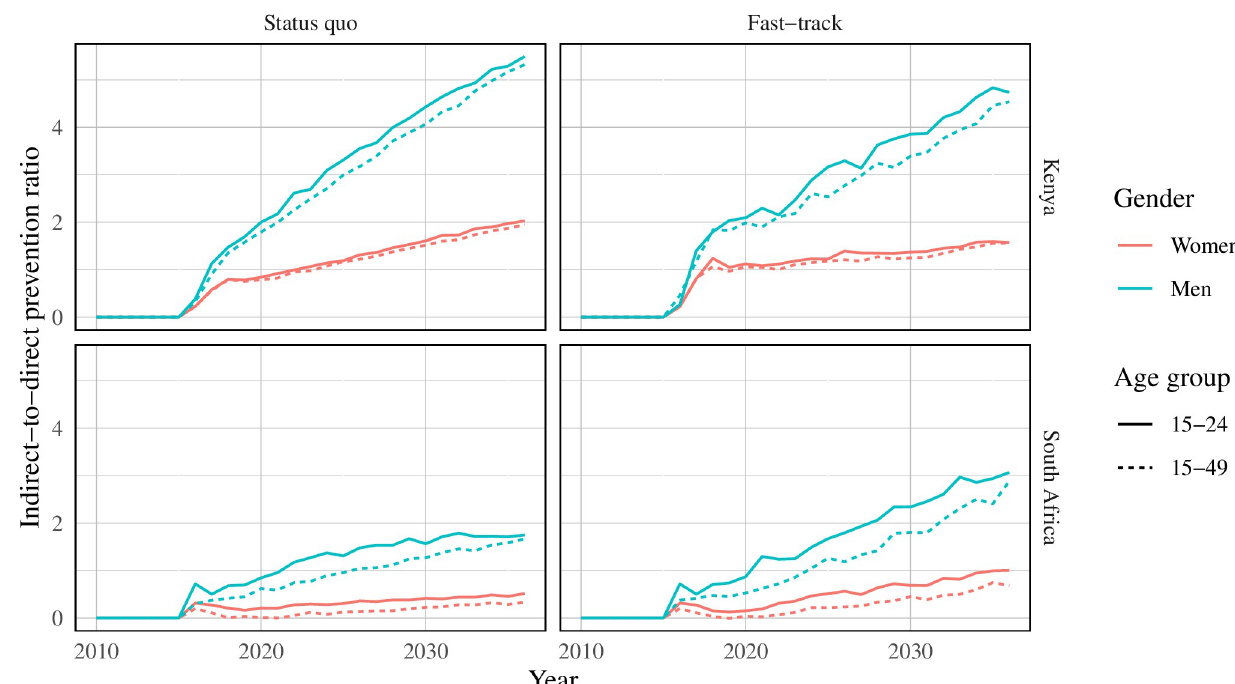
Fig 2. Indirect-to-direct ratio of infections averted in South Africa and Kenya. Scenarios show results from PrEP provision by age and gender.